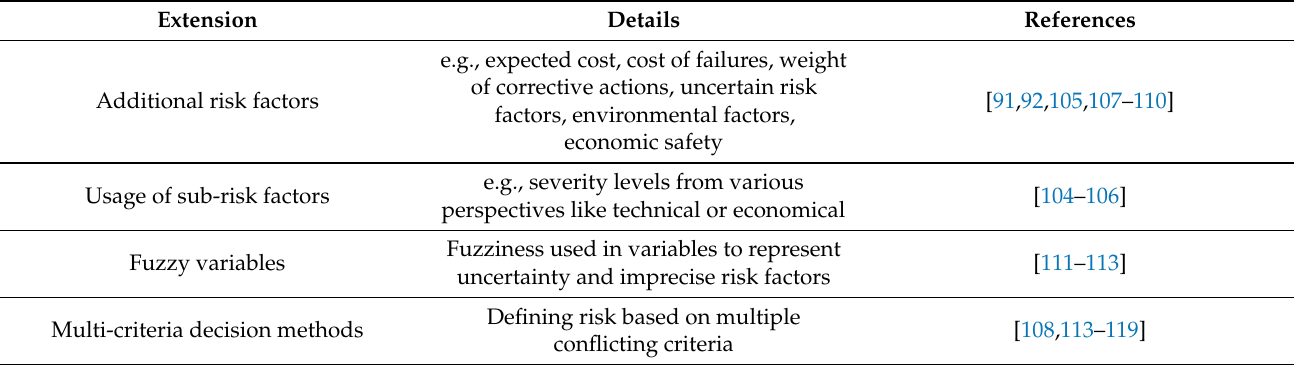
Table 3. Overview of extensions for RPN